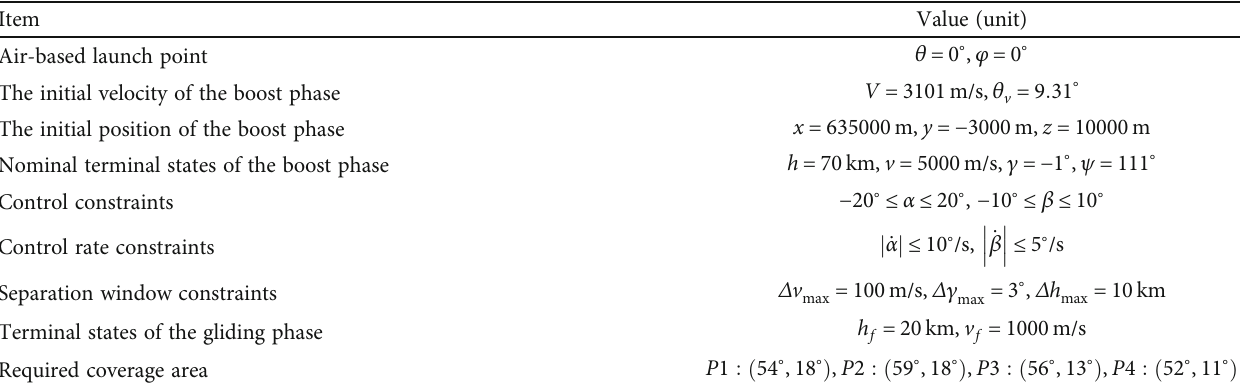
Table 6: Mission parameters.